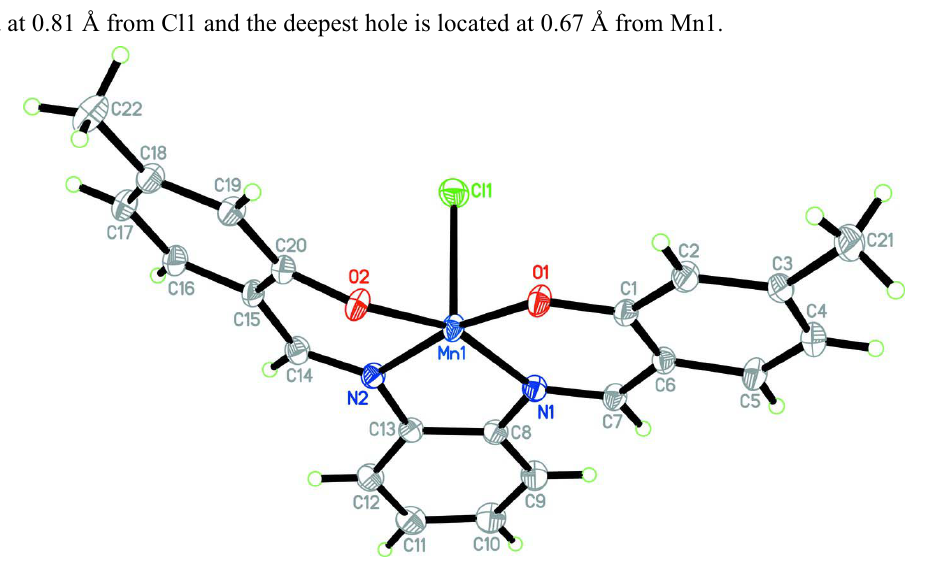
Figure 1 The asymmetric unit of (I), showing 50% probability displacement ellipsoids and the atomic